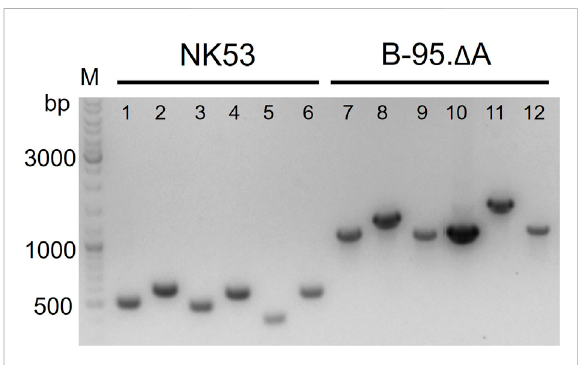
FIGURE 7 Veri fi cation of gene deletions by agarose gel electrophoresis of genomic PCR products. Smaller PCR product sizes indicate deletions within the ampli fi ed DNA region. Comparison of knockout strain B-95. Δ A NK53 to its progenitor E. coli B-95. Δ A used as source of genomic DNA. Lanes: 1) Δ nfsA:FRT; 2) Δ nfsB:FRT; 3) Δ azoR:FRT; 4) Δ ydja:FRT; 5) Δ nemA:FRT; 6) Δ rutE: FRT; lanes 7 – 12 are the corresponding wild-type equivalents.